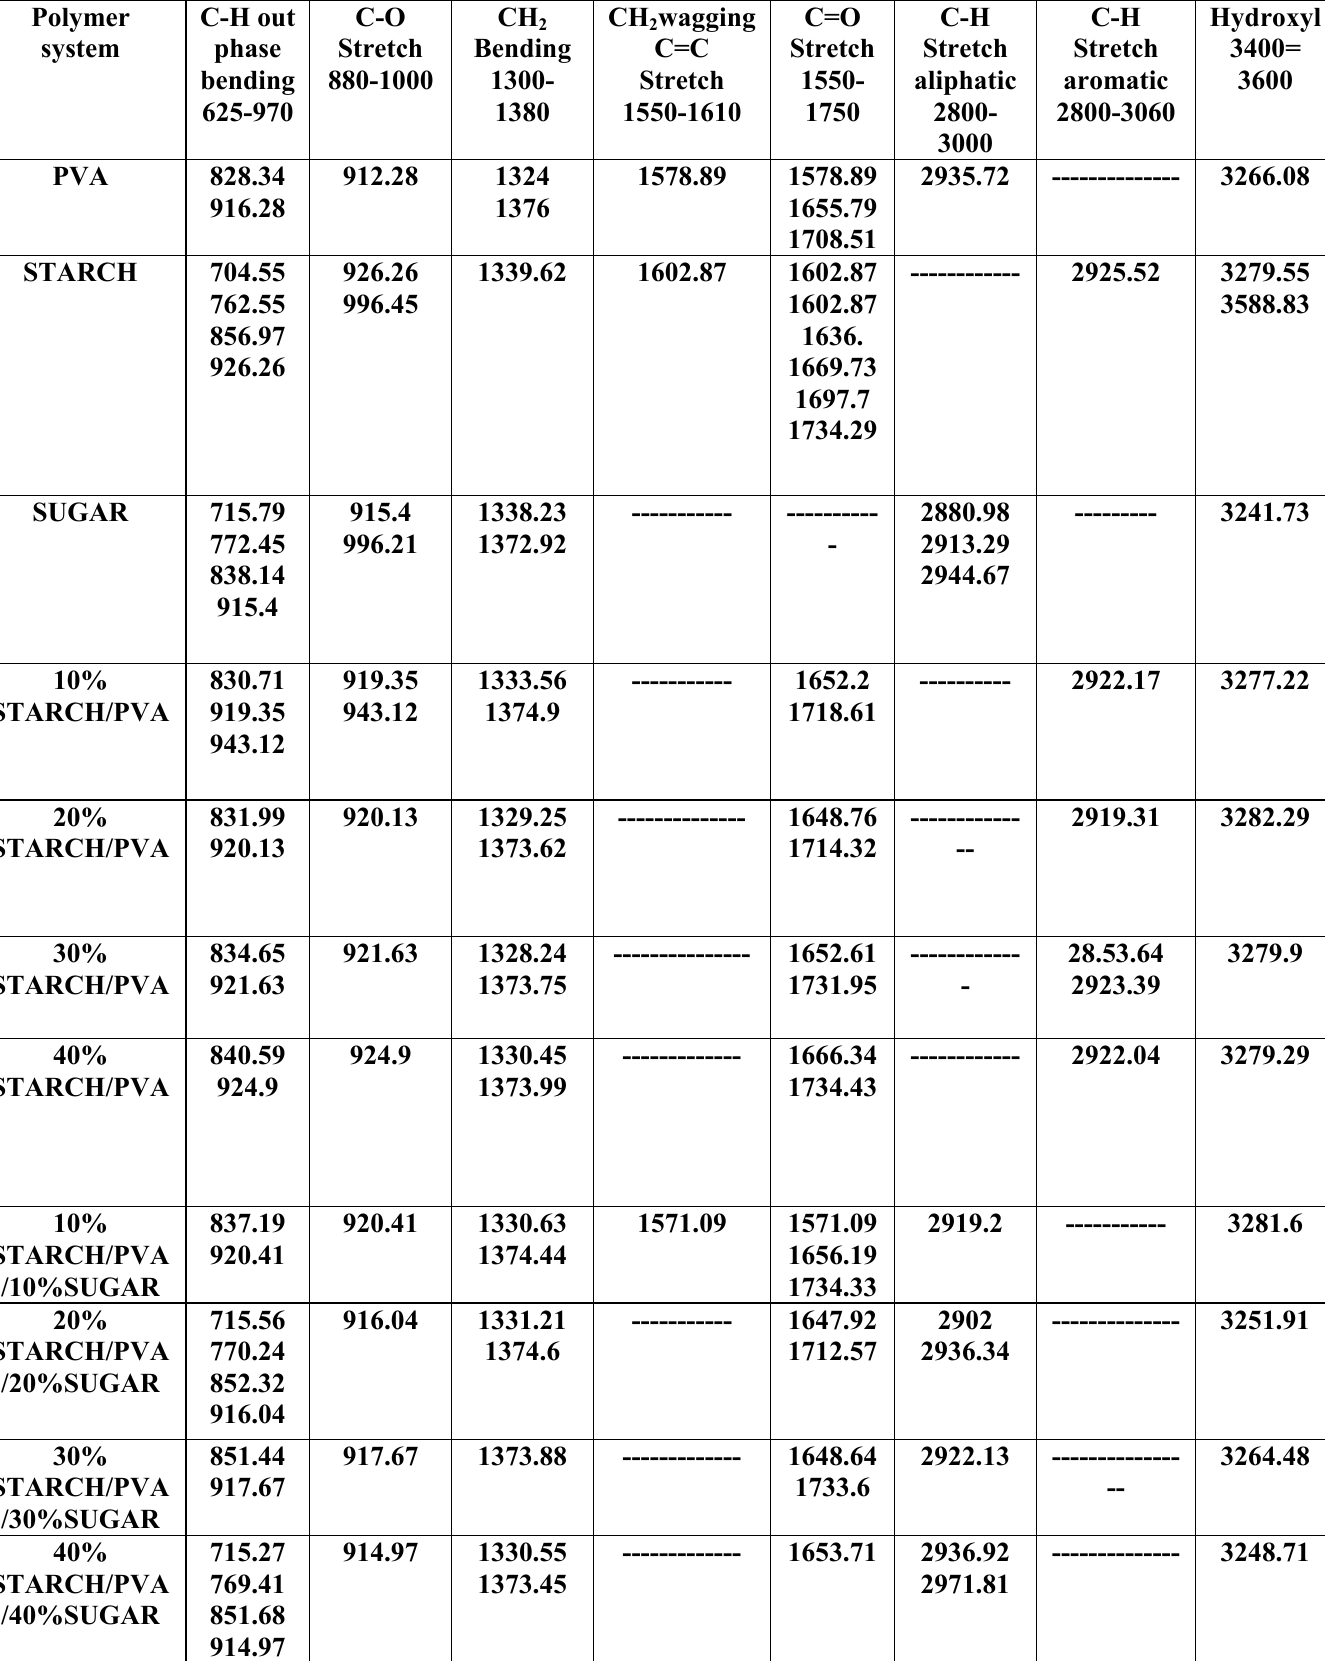
Table 1: The main characteristics of FTIR spectra for the samples involved.